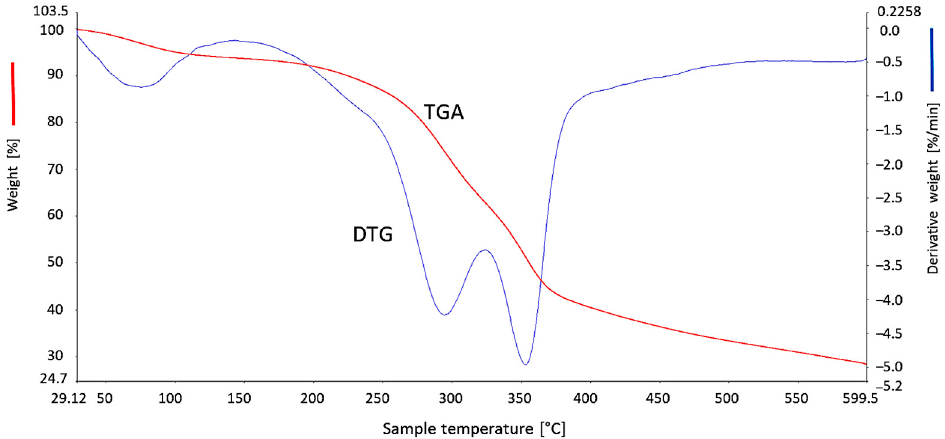
Figure 7. Thermogravimetric curves of brewer’s grains.